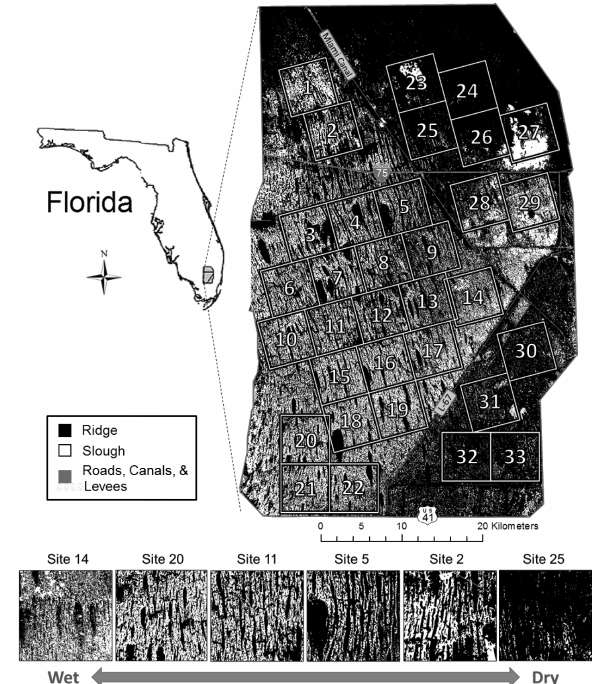
Figure 1. Study area and site locations, including major roads, canals, and levees for the primary map (M1). Sites spanning the pattern gradient in WCA3 are shown in the bottom panel. Two ad- ditional maps (Supplement) were used to corroborate the primary